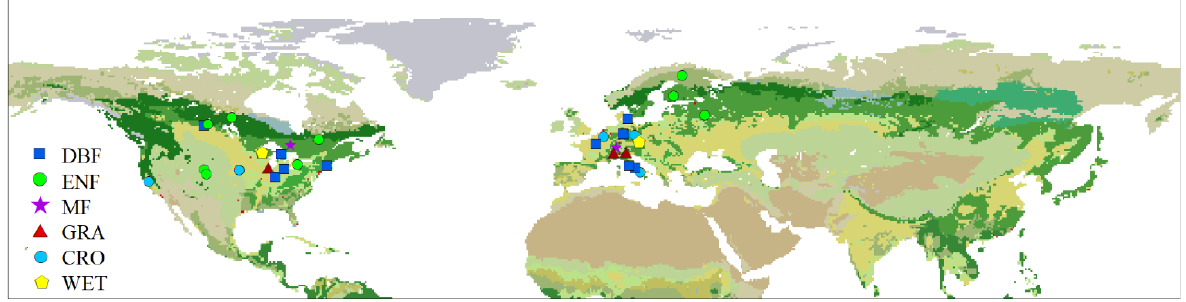
Figure 6. Spatial distribution of eddy covariance flux sites used in this study. DBF, deciduous broadleaf forest; ENF, evergreen needle-leaf forest; MF, mixed forest; GRA, grassland; CRO, cropland; WET, wetland.